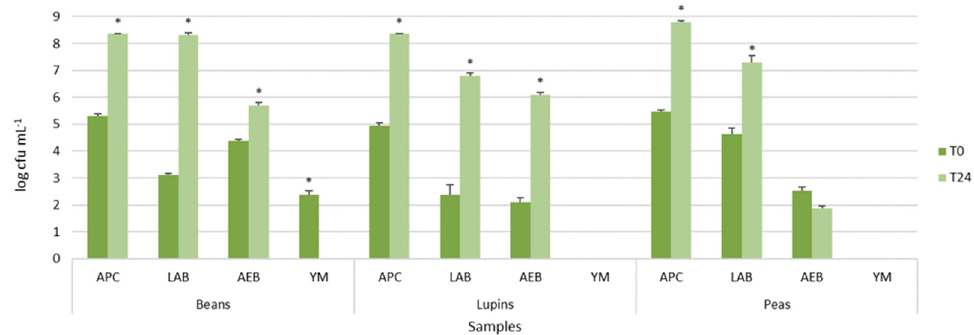
Figure 1. Viable cell counts of main microbial populations of legume grains in water before and after 24 h of incubation at 37 °C. Histograms represent microbial average population values ± standard deviation (error bars). The asterisks indicate statistical differences ( p < 0.05) after T test comparison. Abbreviations: Aerobic Plate Count (APC), Lactic Acid Bacteria (LAB), Aerobic Endospore-Forming Bacteria (AEB), Yeasts and Molds (YM).